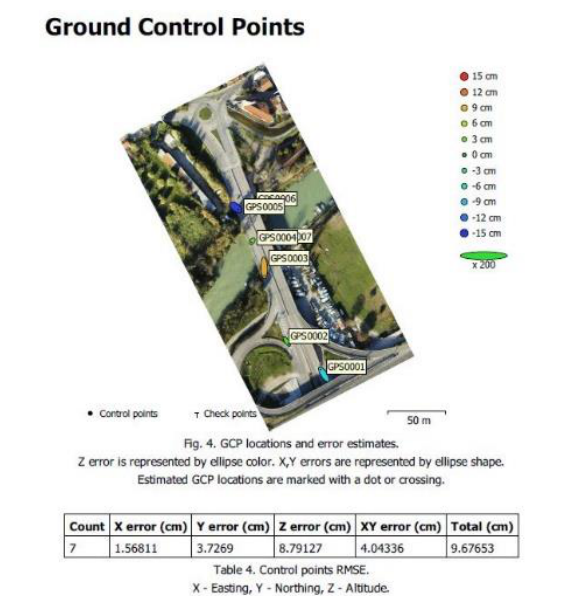
Figure 11: ground verification points. GCP location and error estimates in drone survey.